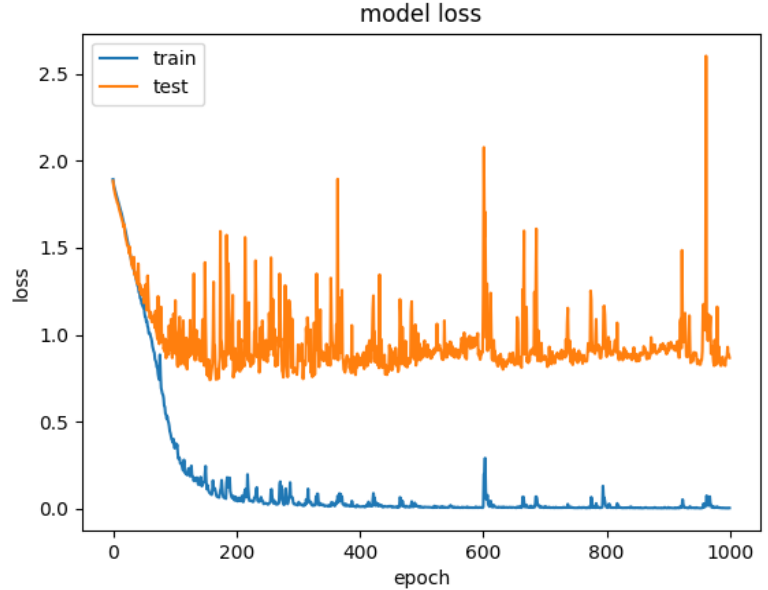
Figure 17. Model loss for CNN+LSTM × 2+Global-Attention.